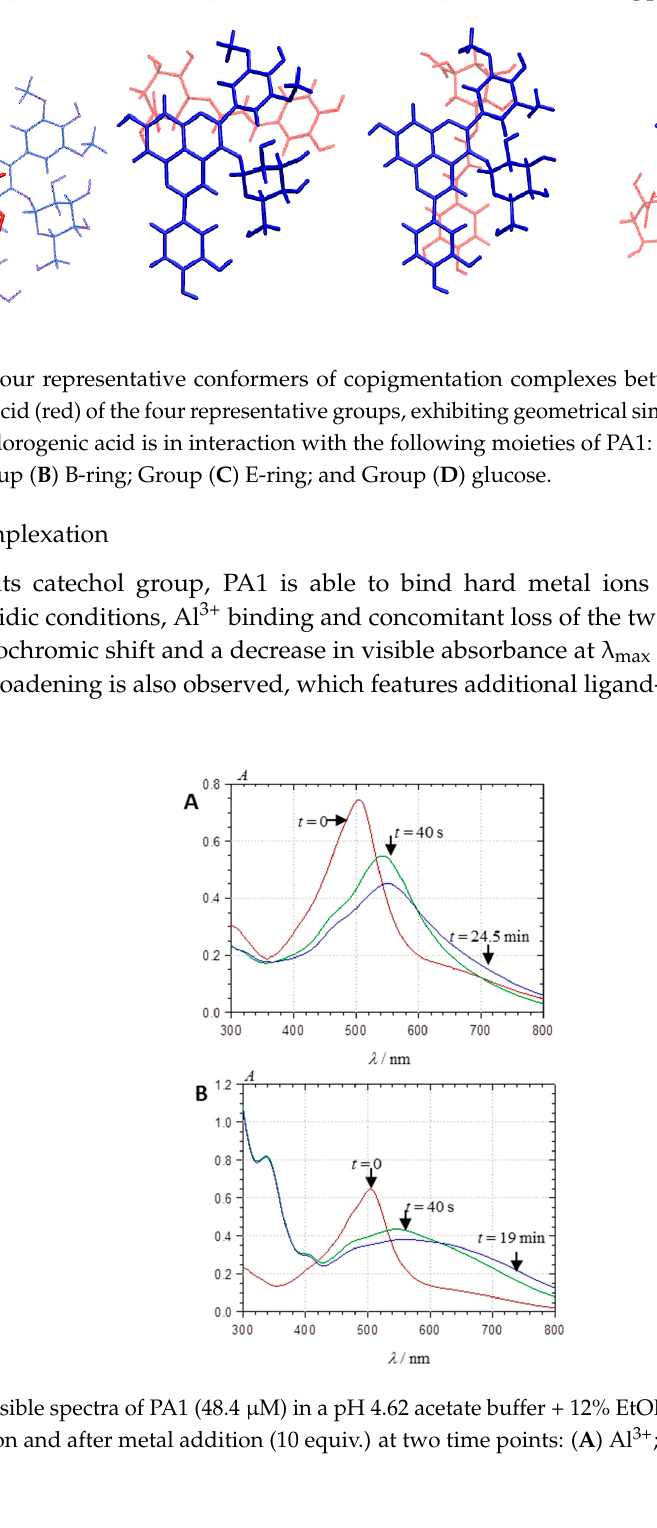
Figure 11. Four representative conformers of copigmentation complexes between PA1 (blue) and